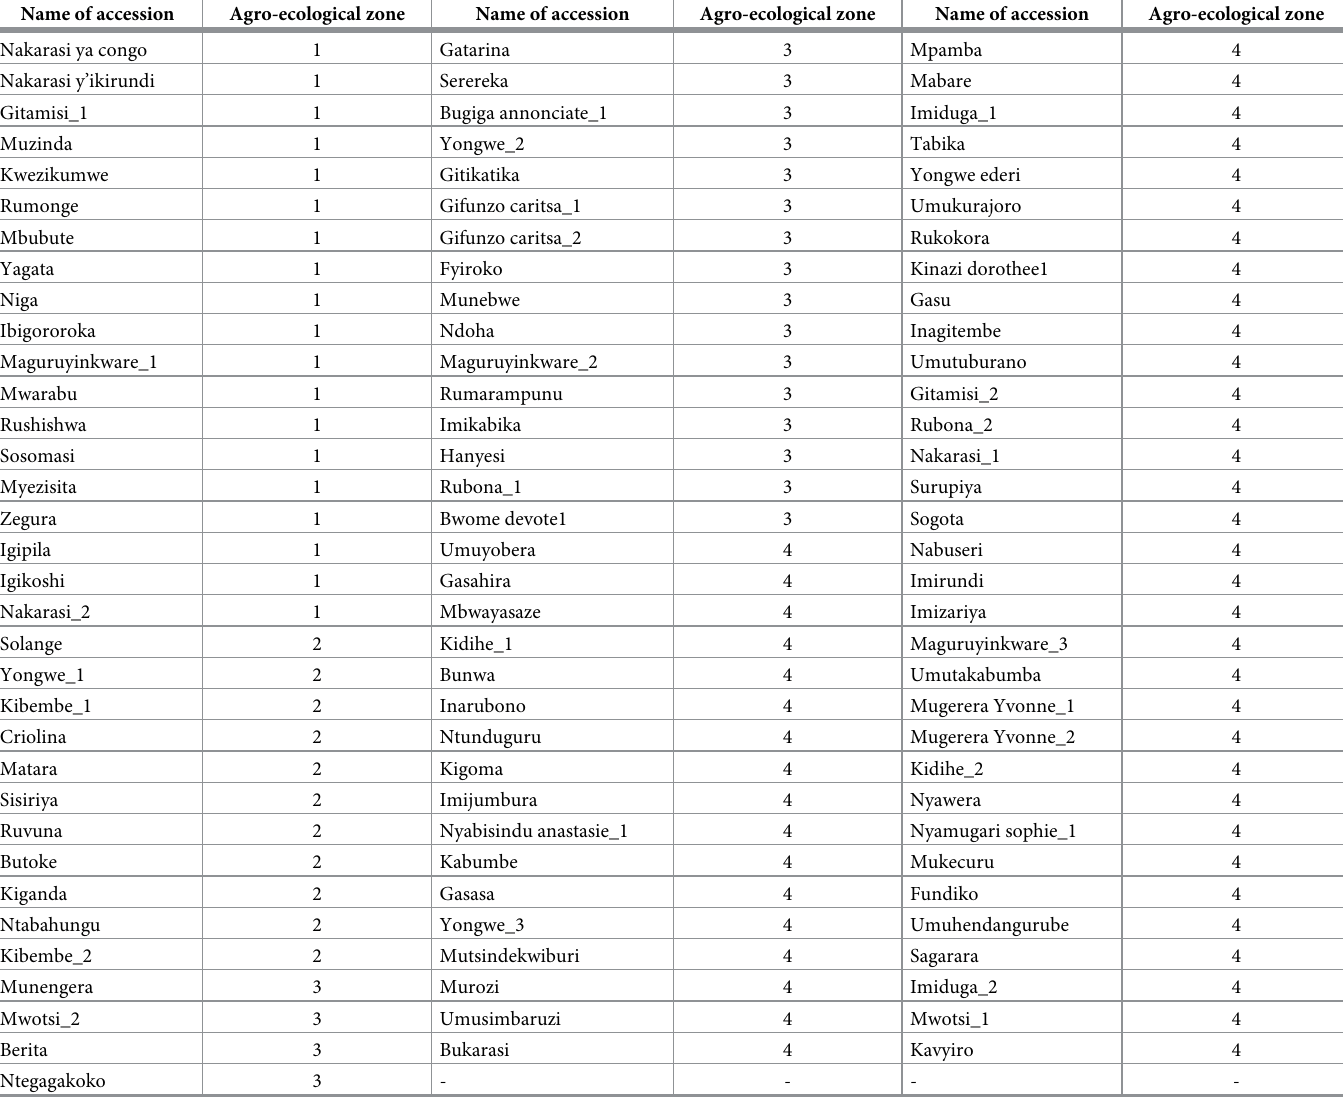
Table 1. Cassava landraces and their region of origin within